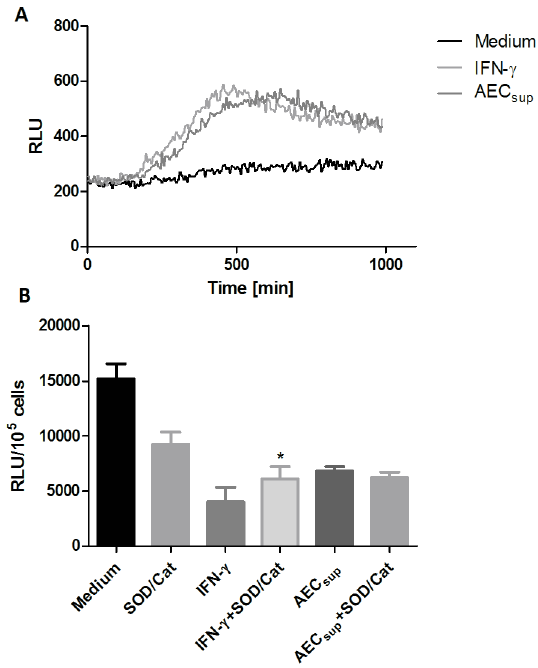
Figure 7. IFN- c and AEC sup induce an oxidative burst following infection with BCG. BMM were treated with IFN- c (20 ng/ml) or AEC sup 24 h prior to infection and then infected with GFP-BCG. a) ROS production was monitored in the cultures for 16 h by measuring luminescence with luminol as substrate. b) The effect of incubating cells with superoxide dismutase (SOD) and catalase on intracellular killing of BCG is shown. Values are expressed as means 6 SD from 5 wells. Differences between treatments with or without SOD/catalase were analyzed using a paired t-test. * significant effect of SOD/catalase treatment, P , 0.05.